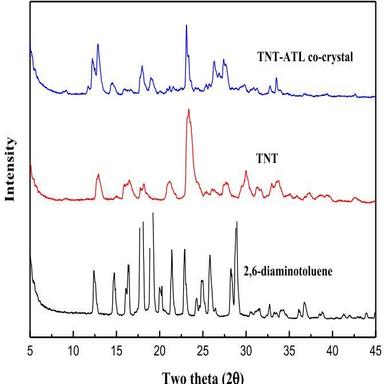
Comparison of PXRD patterns with 2,6-diaminotoluene, TNT and TNT-ATL.